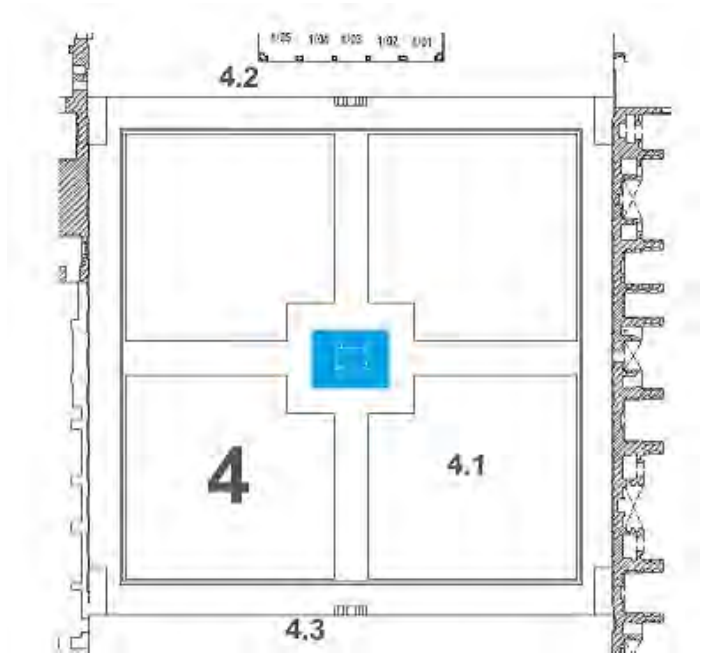
Figure 4. Planof Shah Jahan’s Quadrangle